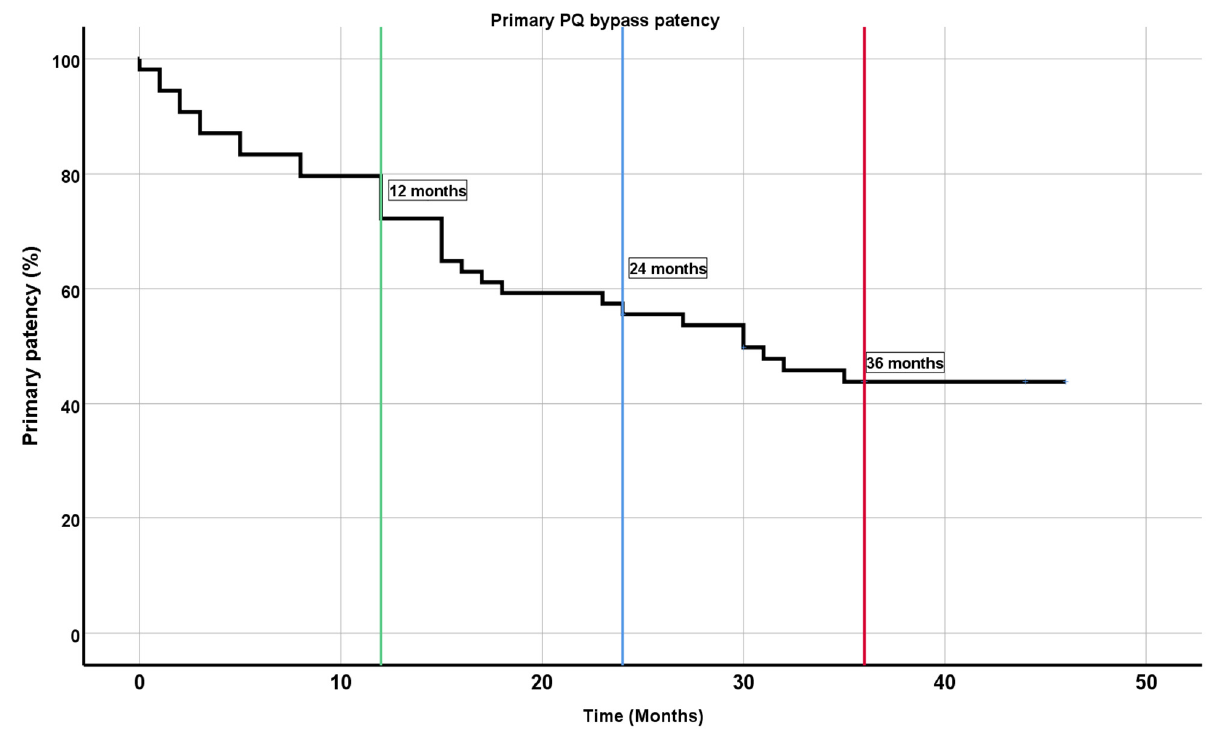
Figure 2. Kaplan–Meier plot for primary patency at 1 year (green line), 2 years (blue line), and 3 years (red line). PQ bypass, percutaneous endovascular transvenous femoropopliteal bypass.